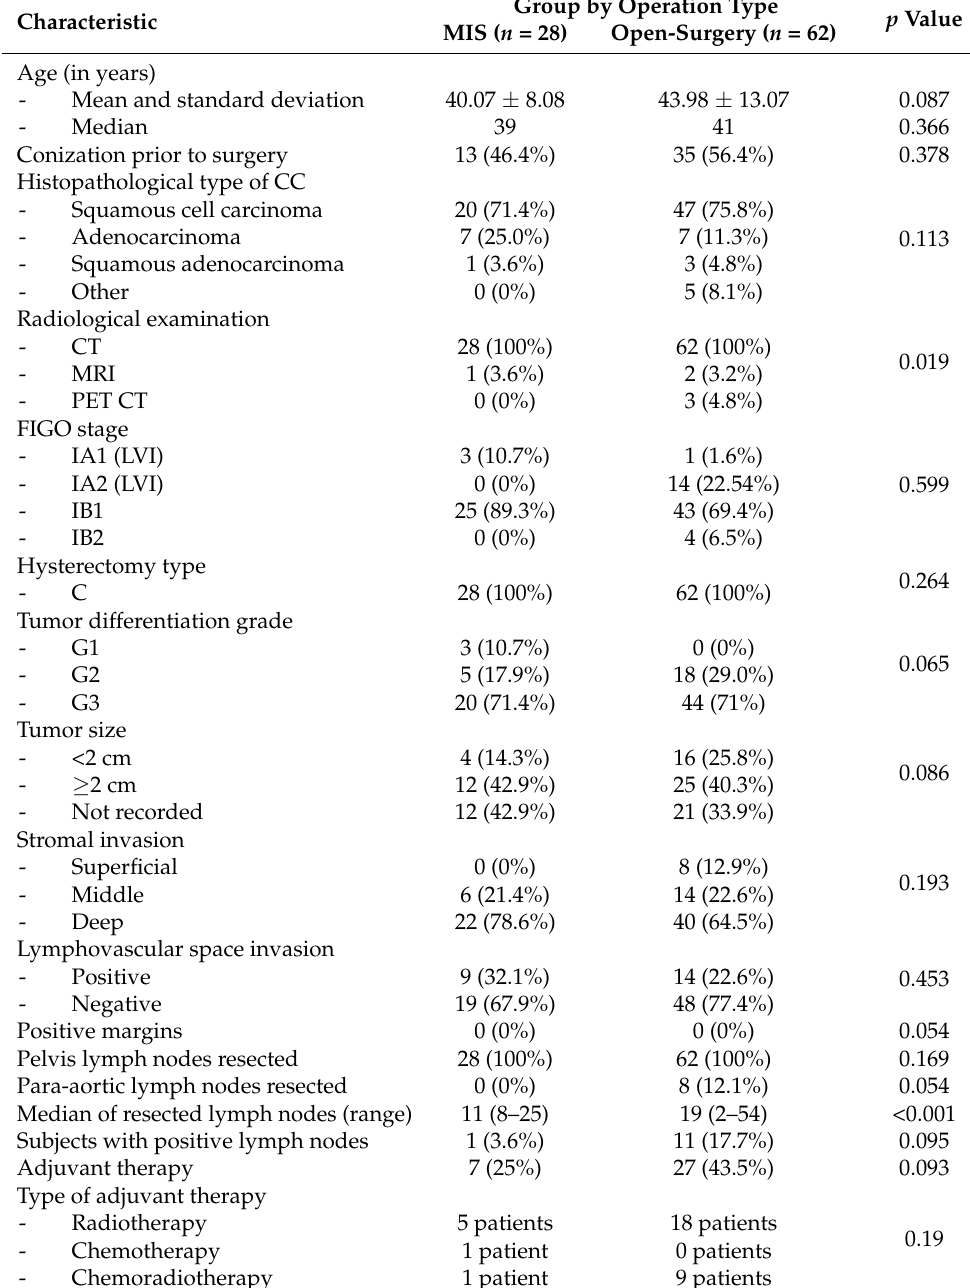
Table 1. Patient disease, tumor, and treatment characteristics considering MIS and open-surgery